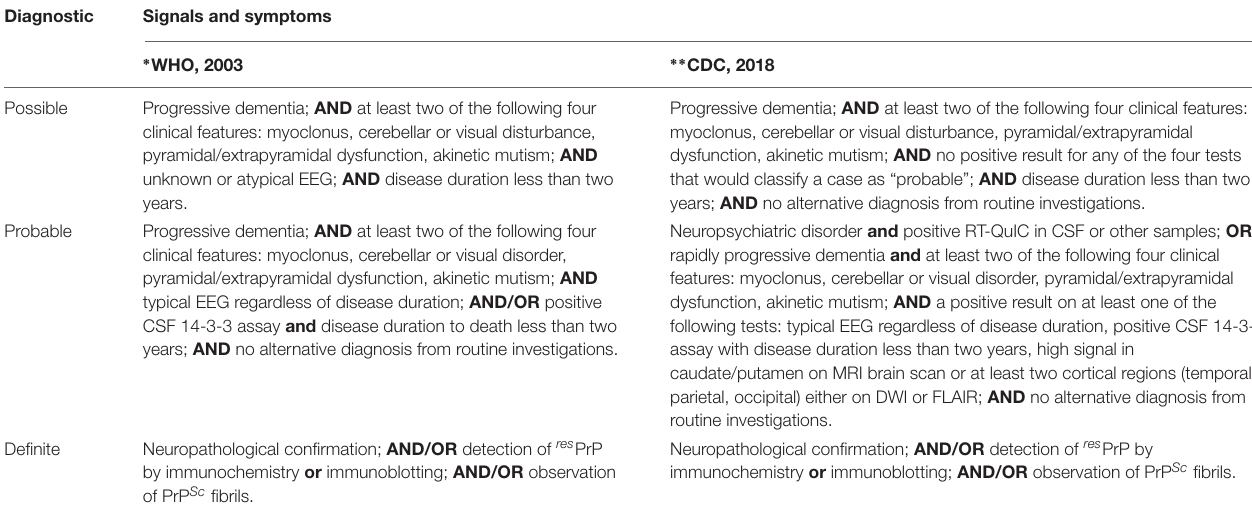
TABLE 5 | Current guidelines for sCJD